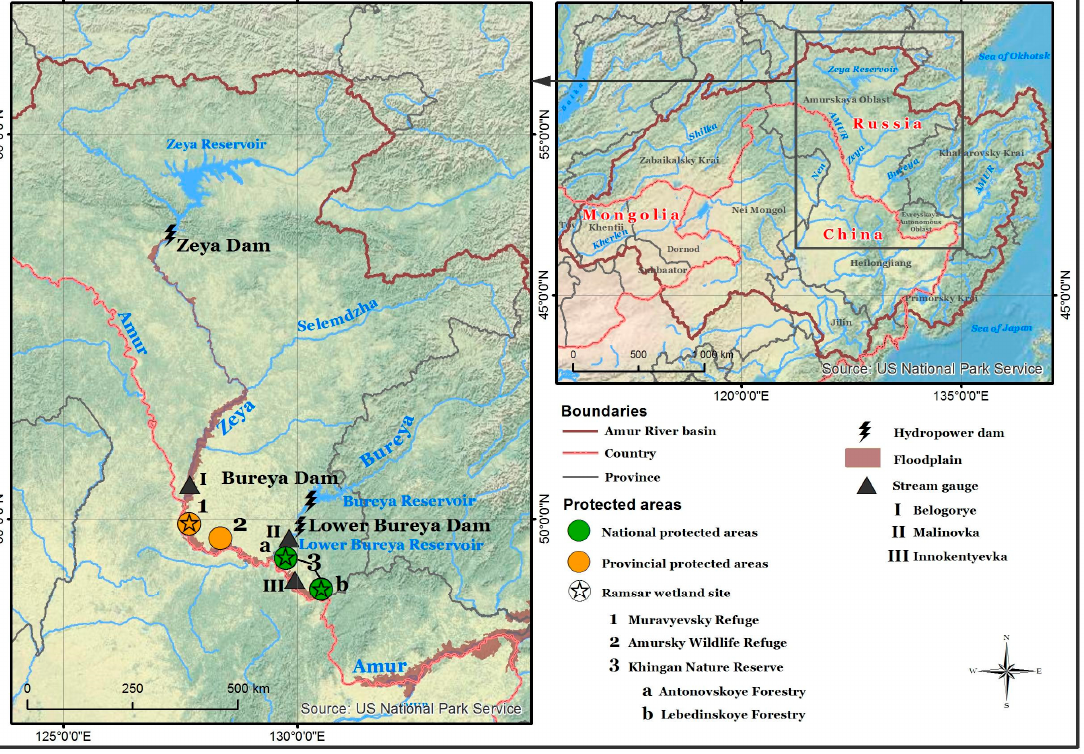
Figure 1. Large dams in the Russian part of the Amur River basin and the important wetlands, including Ramsar sites, located within protected areas under the dam